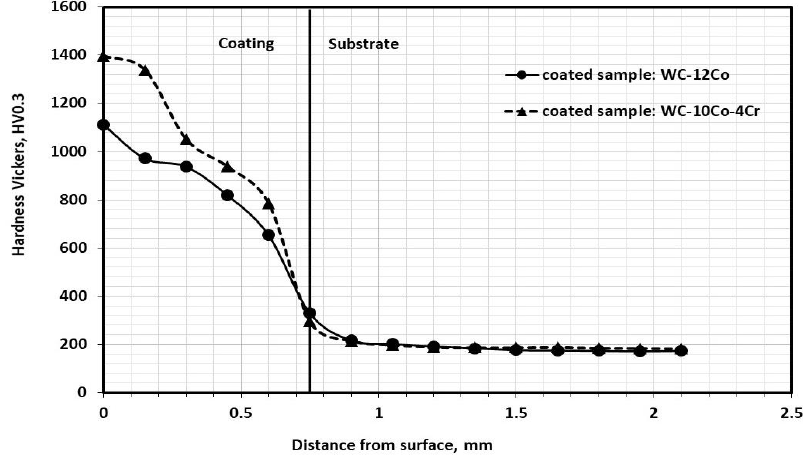
Figure 15. Microhardness distribution along the coated samples